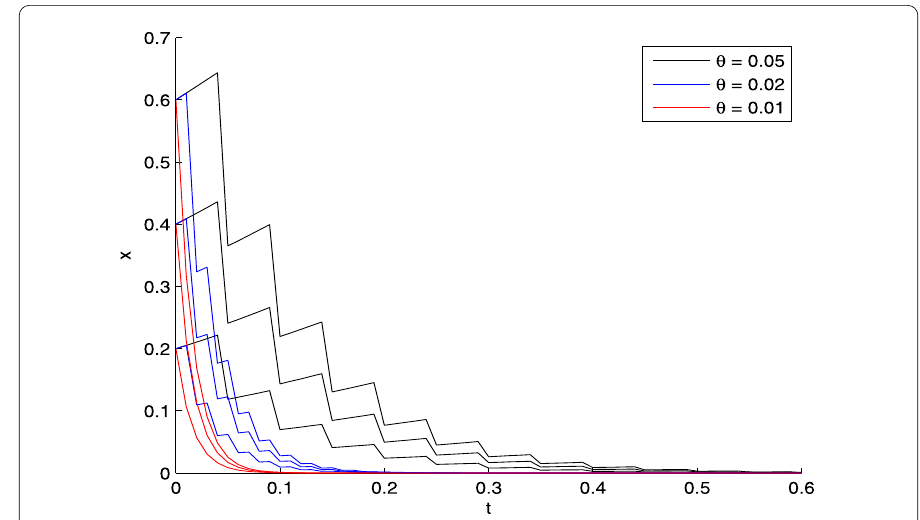
Figure 3 Dynamic behaviors of the species x ( t ) in system (1.4) with the initial conditions x (0) = 0.2, x (0) = 0.4, x (0) = 0.6, respectively